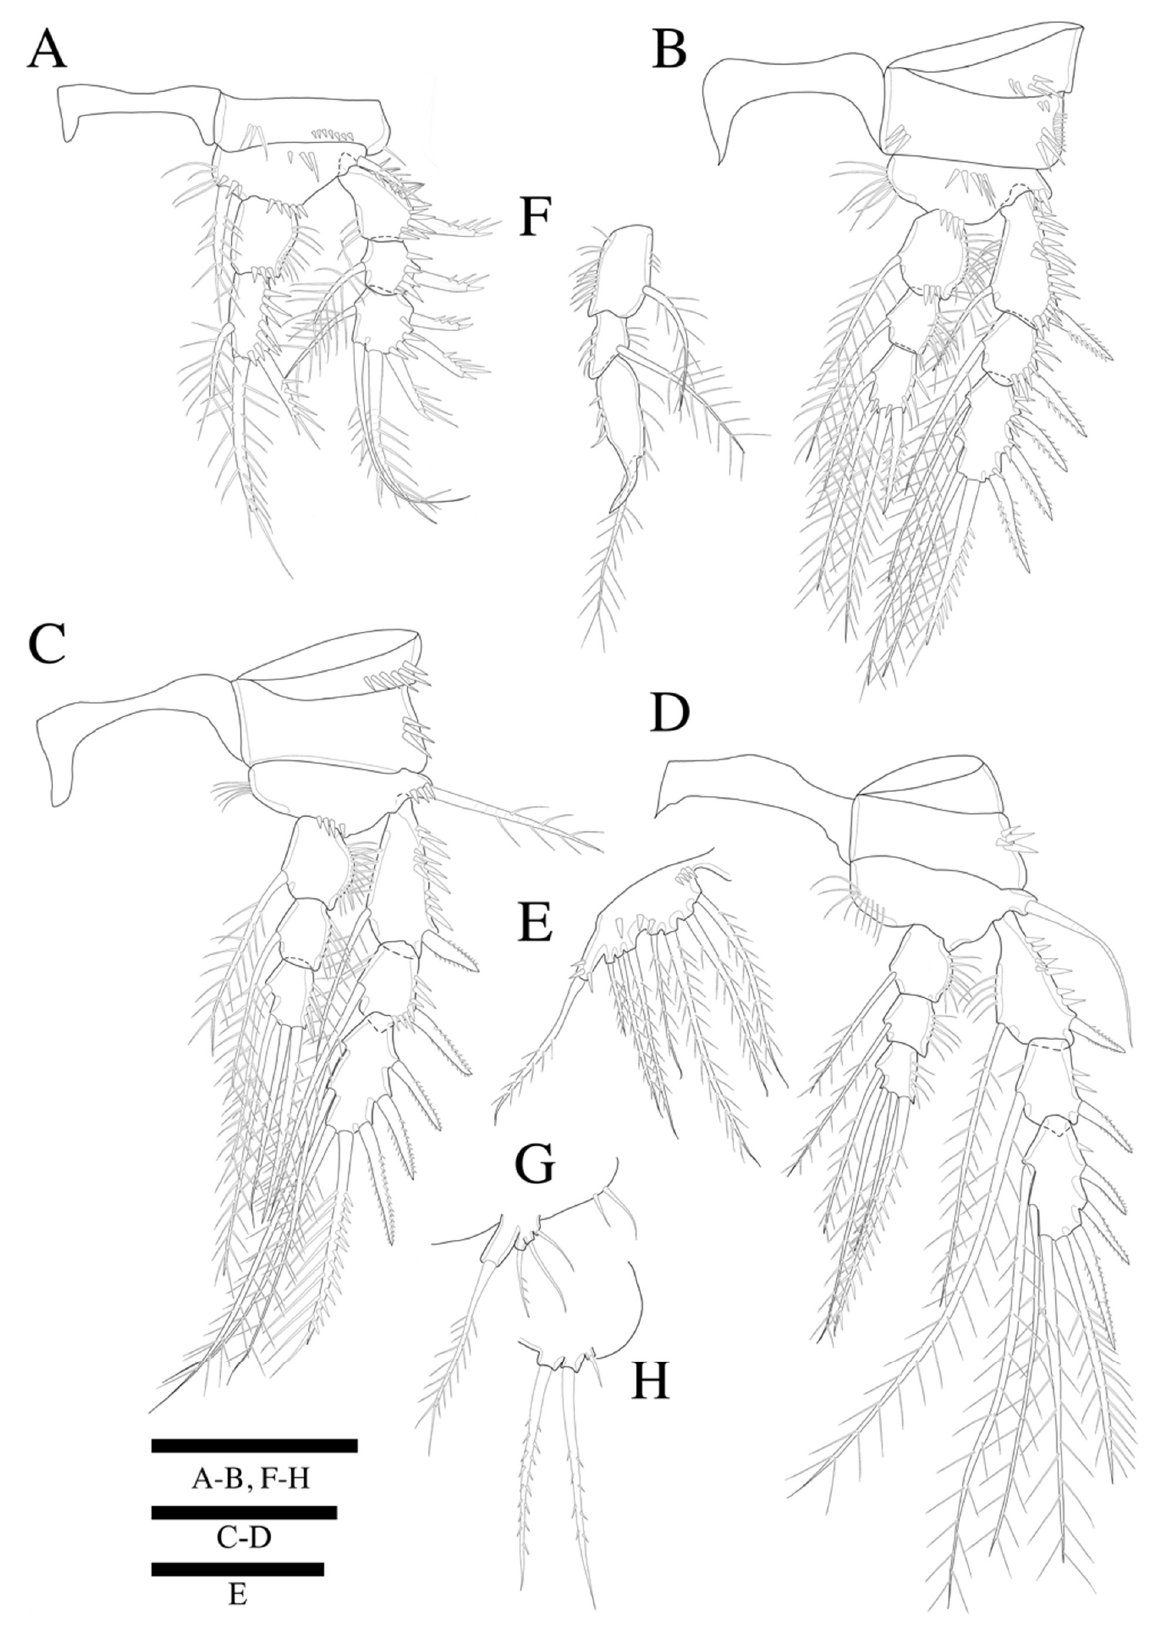
Figure 8. Zosime thistlei sp. nov. Female. ( A ) P1; ( B ) P2; ( C ) P3; ( D ) P4; ( E ) P5. Male. ( F ) P2 endopod; ( G ) P5; ( H ) P6. Scale bars: 50 µm.